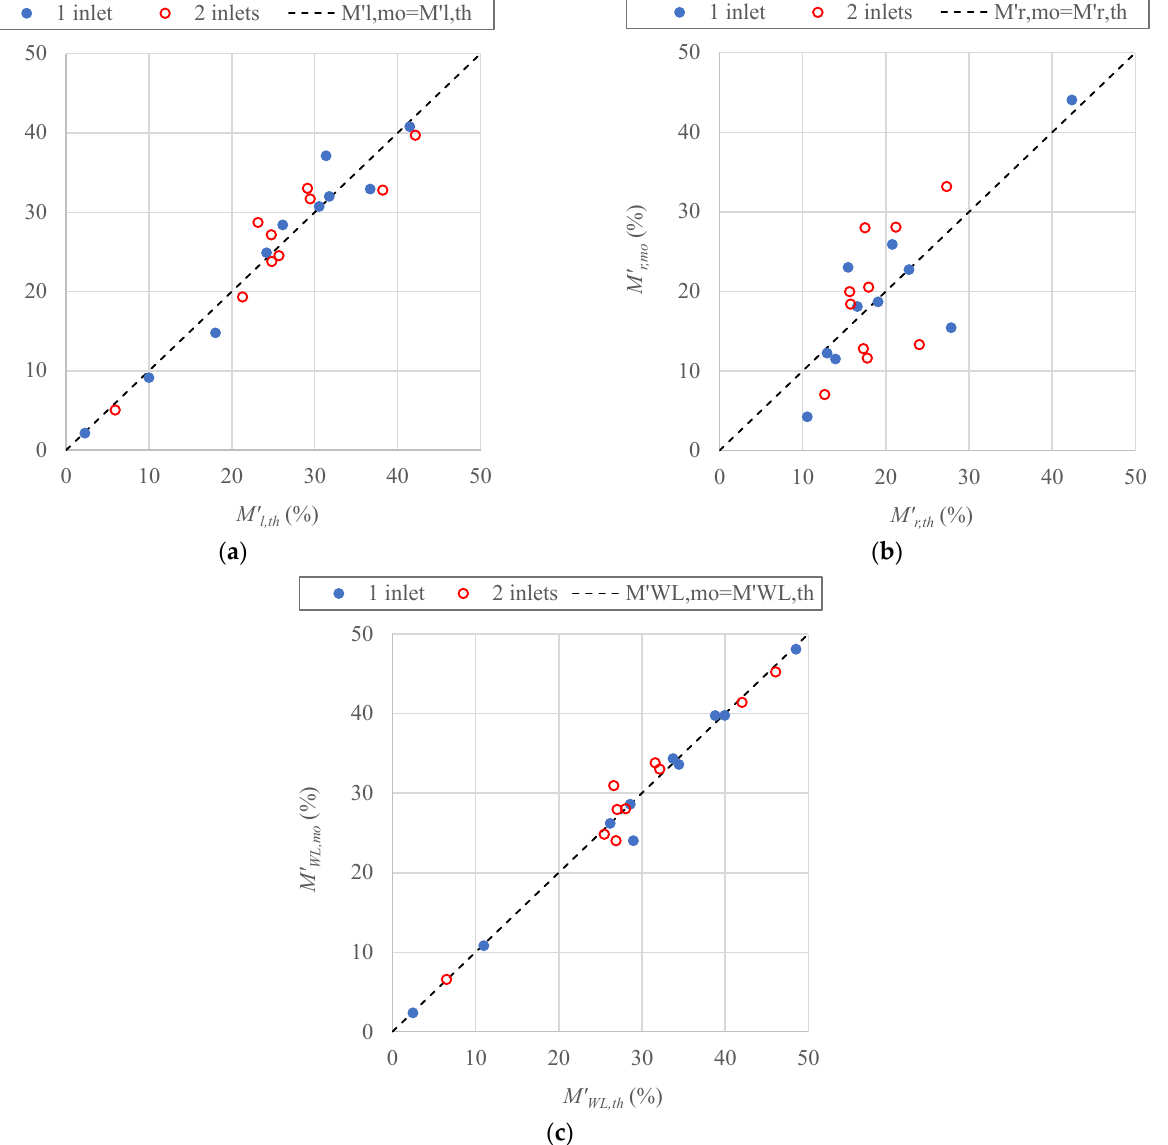
Figure 7. Comparison between the disinfectant mass balance components calculated using EPANET models and the ones estimated by theory. ( a ) M (cid:48) M (cid:48) WL , th